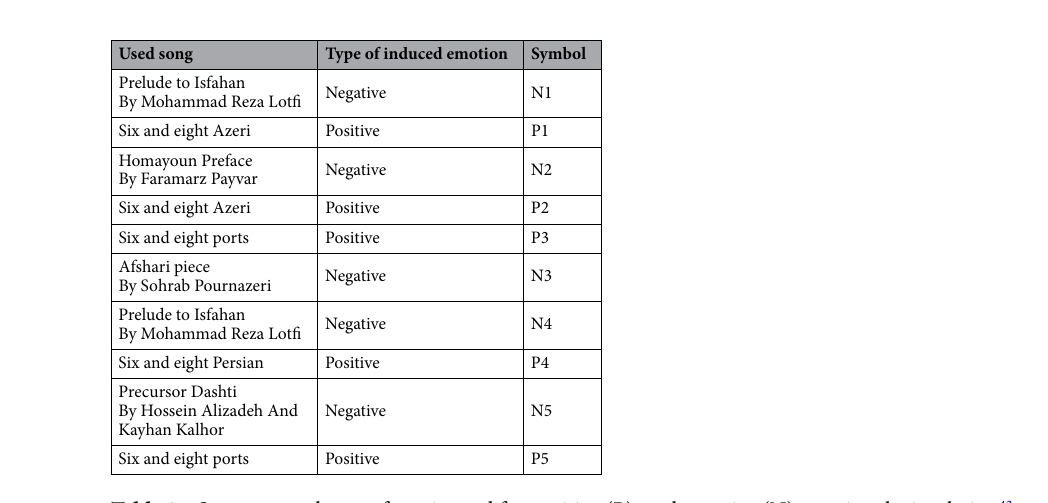
Table 2. Sequence and type of music used for positive (P), and negative (N) emotional stimulation 43